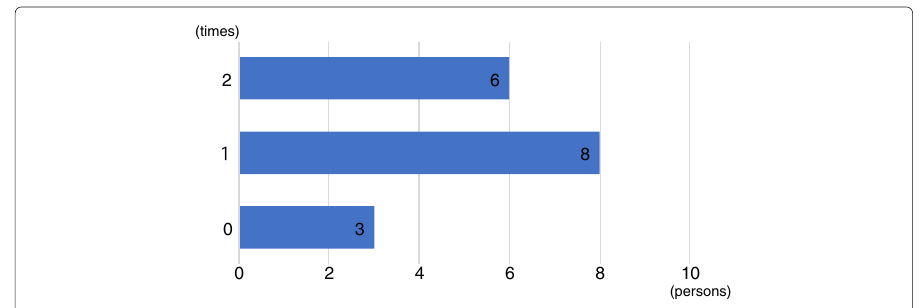
Fig. 13 The number of accesses to the SNS after the completion of workshops